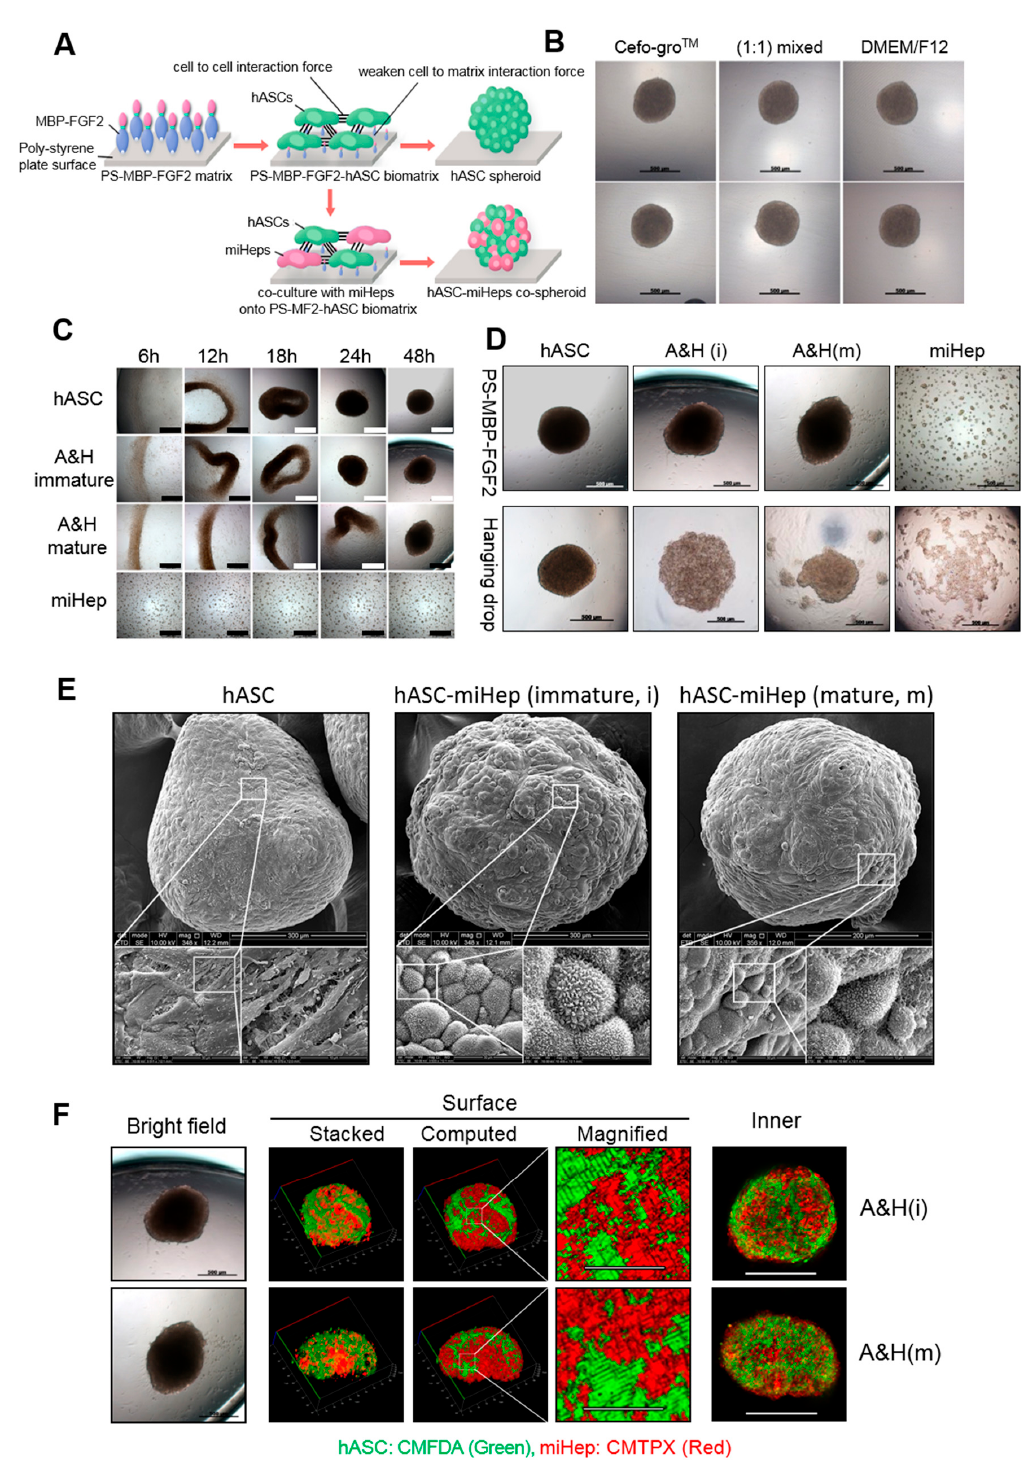
Figure 2. hASC-miHep co-spheroid formation and morphological characteristics. ( A ) Schematic overview of spheroid formation on PS-MBP-FGF2. ( B ) hASCs (1 × 10 4 cells) were incubated with indicated media form hASCs spheroid in the MBP-FGF2-coated 384 well PS plate; the upper and lower images are duplicates observed by independent experiments. ( C ) hASC-miHeps co-spheroid formation. Immature or mature miHeps were co-cultured with hASCs to form co-spheroids using